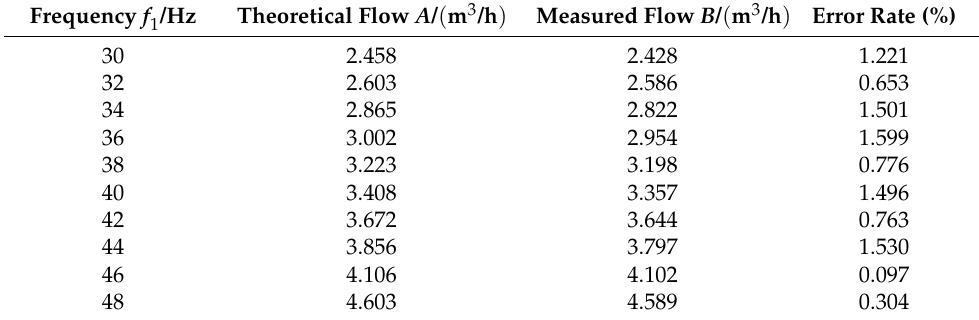
Table 3. Test results collection.